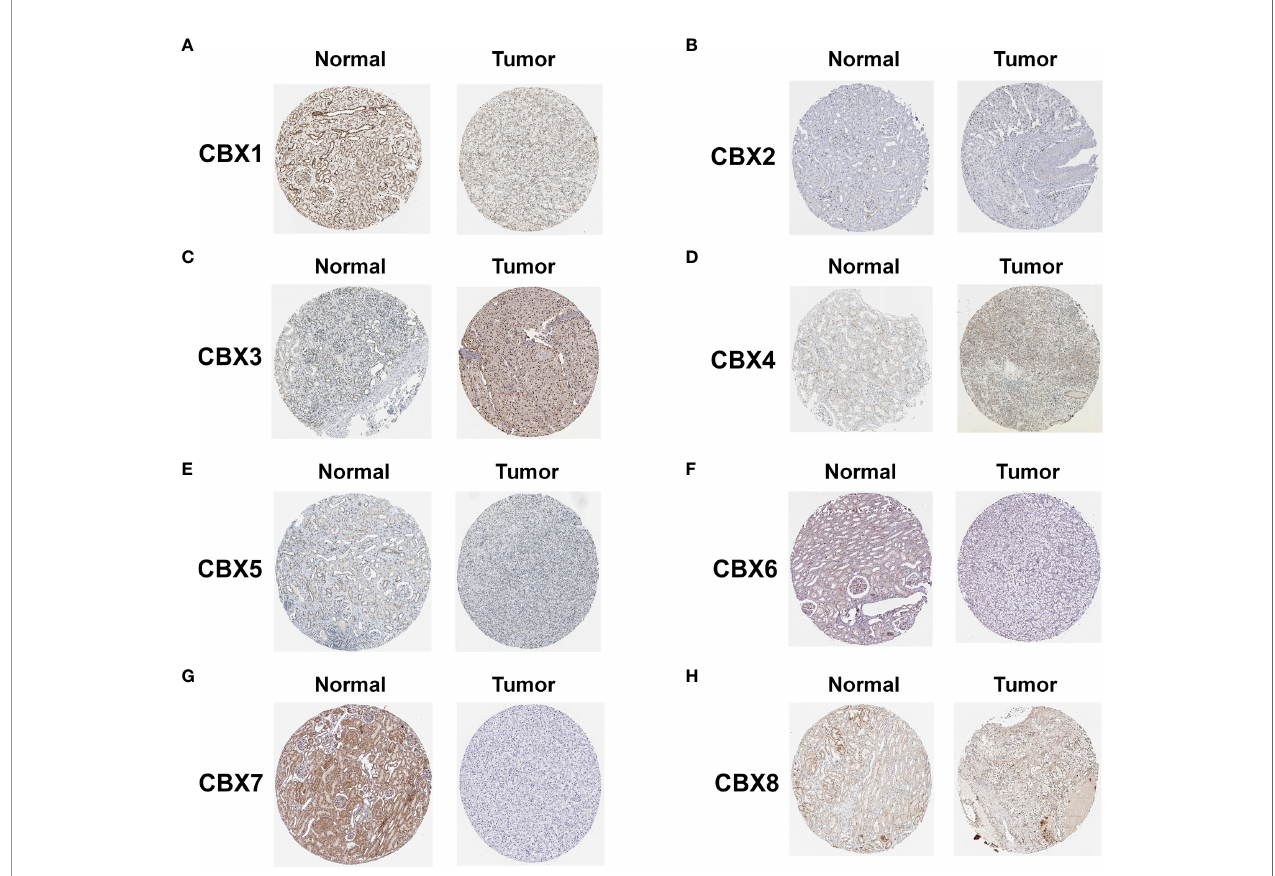
FIGURE 4 | The protein expression of CBXs in normal kidney tissues and ccRCC tissues (Human Protein Atlas). The protein expression of CBX3 and CBX4 in ccRCC tissues were signi fi cantly elevated compared with normal kidney tissues (C, D) , while the protein expression of CBX1,CBX5, CBX6, CBX7 were signi fi cantly reduced in ccRCC tissues (A, E – G) . The CBX2 and CBX8 were expressed at similar levels in ccRCC tissues and normal kidney tissues (B, H)